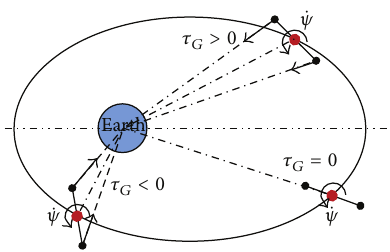
Figure 17: Schematic of the effect of the gravity gradient torque on the pitch angular velocity with different